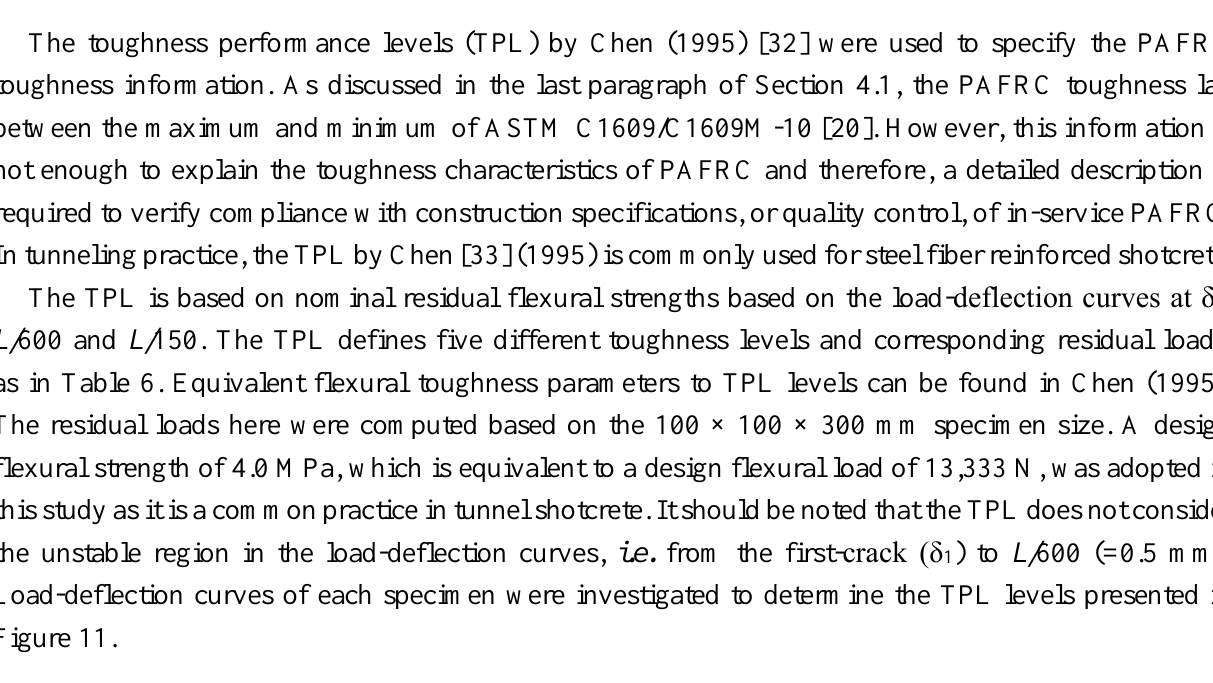
Figure 11. Toughness performance level . ( a ) PA-7-RFA50; ( b ) PA-8-RFA50; ( c ) PA-9-RFA50; ( d ) PA-7-RFA60; ( e ) PA-8-RFA60; ( f ) PA-9-RFA60; ( g ) PA-10-RFA60; ( h ) TPL